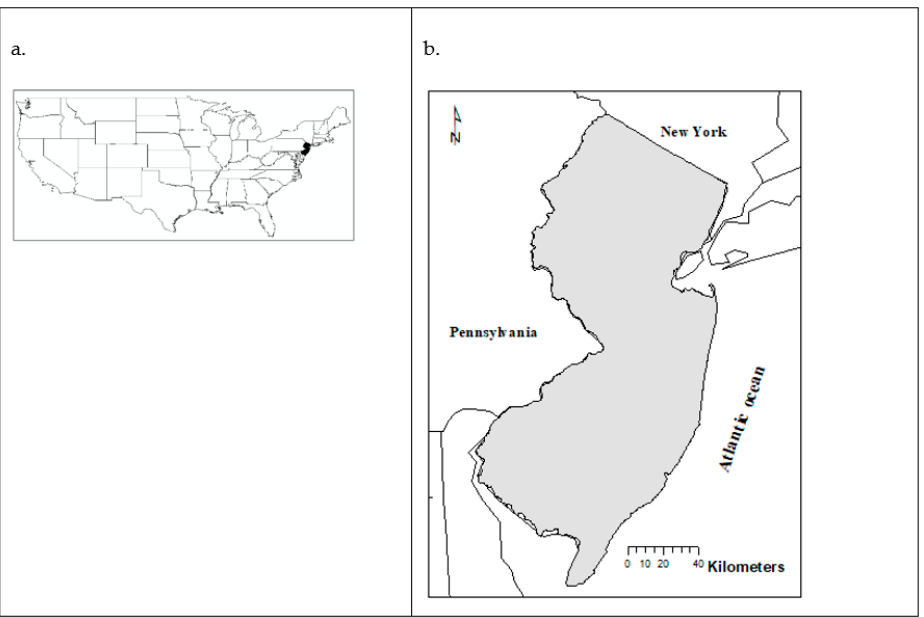
Figure 1. Study area: ( a ) The map of the United States of America with the state of New Jersey in black color on the eastern coast. ( b ) A larger map of New Jersey .